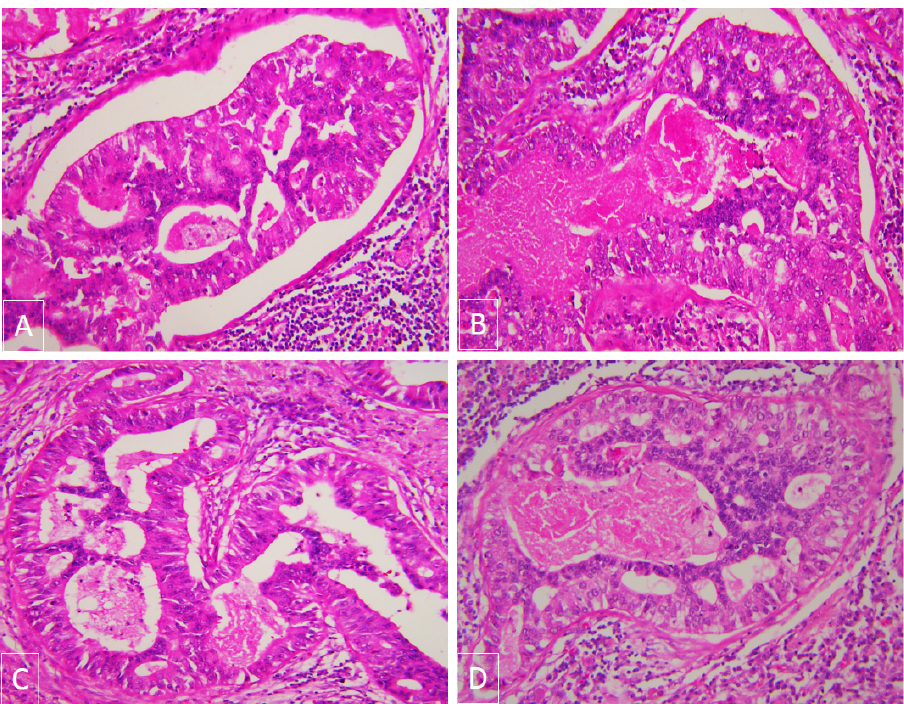
Figure 2. H&E: ( A ) and ( B ) adenocarcinoma, enteric pattern with large complex glands, ( C ) cribiform and solid growth patterns, plus ( D ) central necrosis.